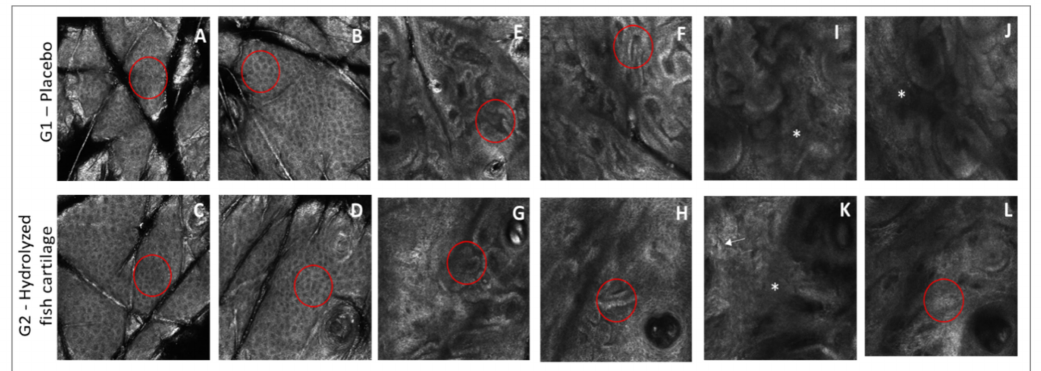
Figure 7. Representative reflectance confocal microscopy (RCM) images of the stratum granulosum of the skin. ( A ) Irregular honeycomb pattern and low interkeratinocyte reflectance (red circle) before supplementation with the placebo. ( B ) Regular honeycomb pattern and interkeratinocyte brightness (red circle) after supplementation with the placebo. ( C ) Irregular honeycomb pattern and low interkeratinocyte reflectance (red circle) before supplementation with hydrolyzed fish cartilage. ( D ) Regular honeycomb pattern and higher interkeratinocyte brightness (red circle) after supplementation with hydrolyzed fish cartilage. Representative RCM images of the dermal-epidermal junction. ( E ) Polycyclic papillary contours (red circle) before supplementation with the placebo; ( F ) polycyclic papillary contours (red circle) after supplementation with the placebo; ( G ) polycyclic papillary contours (red circle) before supplementation with hydrolyzed fish cartilage; ( H ) polycyclic papillary contours (red circle) after supplementation with hydrolyzed fish cartilage. Representative RCM images of the papillary dermis. ( I ) Huddled collagen structures (asterisks) before supplementation with placebo; ( J ) huddled collagen structures (asterisks) after supplementation with placebo; ( K ) huddled collagen structures (asterisks) with curled bright structures-elastosis (arrow) before supplementation with hydrolyzed fish cartilage; and ( L ) coarse collagen structures (red circle) after supplementation with hydrolyzed fish cartilage (Scale: 500 × 500 µ m).